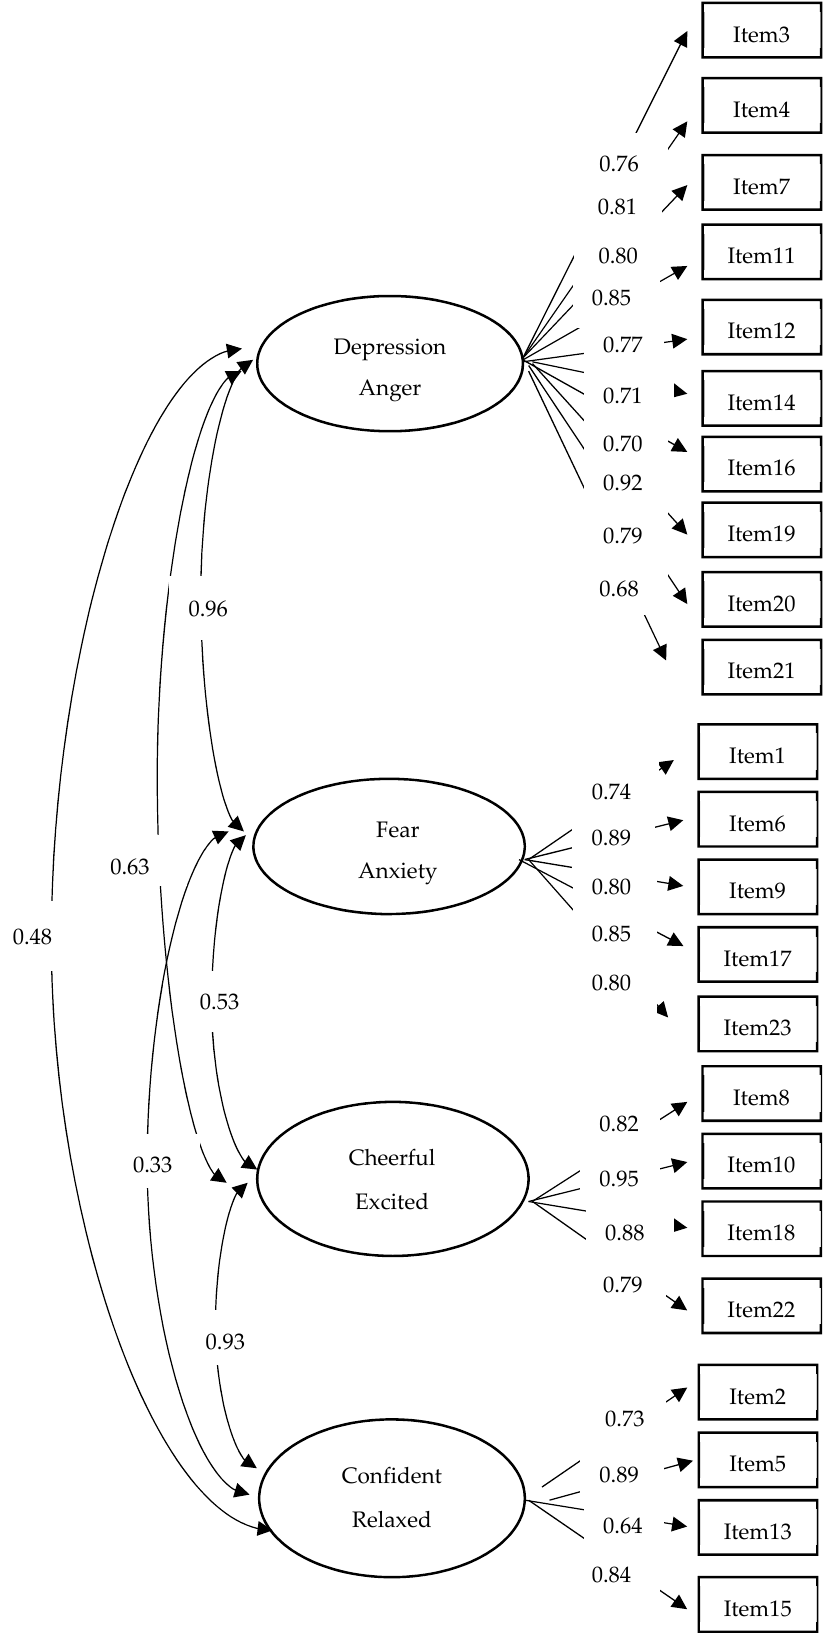
Figure 1. Standardized factor loadings for the four-factor